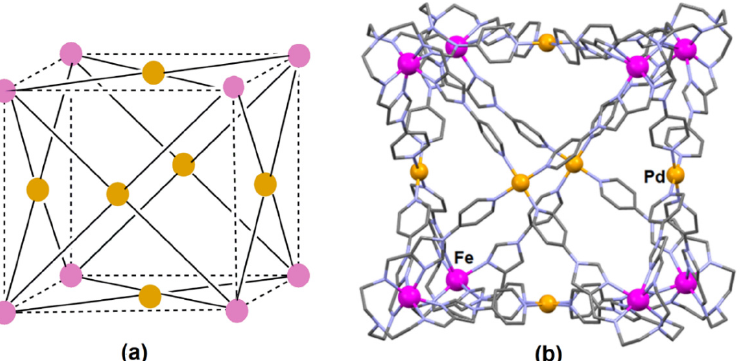
Figure 7. Structural details of the cubic cation in [Fe 8 Pd 6 L 8 ](BF 4 ) 28 ( 9 ) (where FeL = 8 ). ( a ) Schematic representation of the metal ion sites in the face-centred cube. ( b ) Crystal structure of the cubic cation showing the octahedral coordination geometry of each iron(II) centre which is bound to six imidazole imine nitrogen donors and the square planar coordination of each palladium(II) site, which is bound to four pendent 4-pyridyl groups. Hydrogen atoms and BF 4- anions are not shown [111].